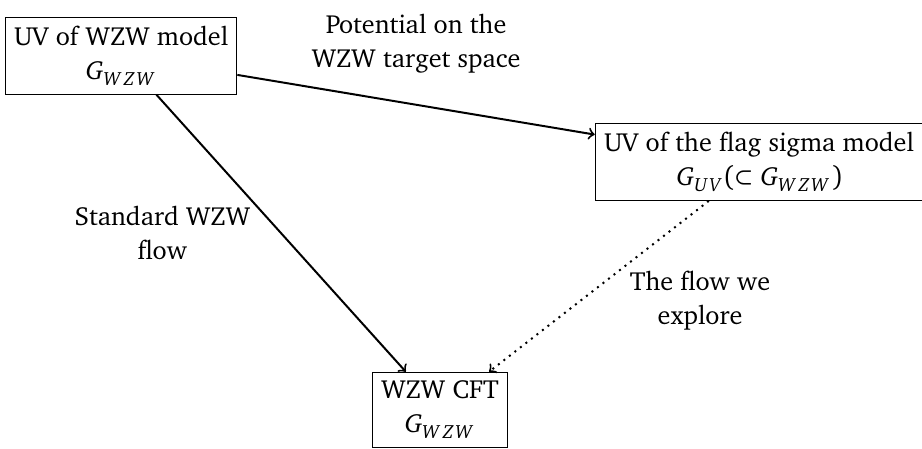
Figure 1: The UV WZW model flows in the IR to the WZW CFT. This flow preserves the full G global symmetry. Here we deform this UV theory by a potential that restricts the WZW field to take values in the flag M and breaks the WZW symmetry to G explore whether the sigma model can flow to the WZW CFT (dashed line in the diagram). The global symmetry of each theory in the figure is written below